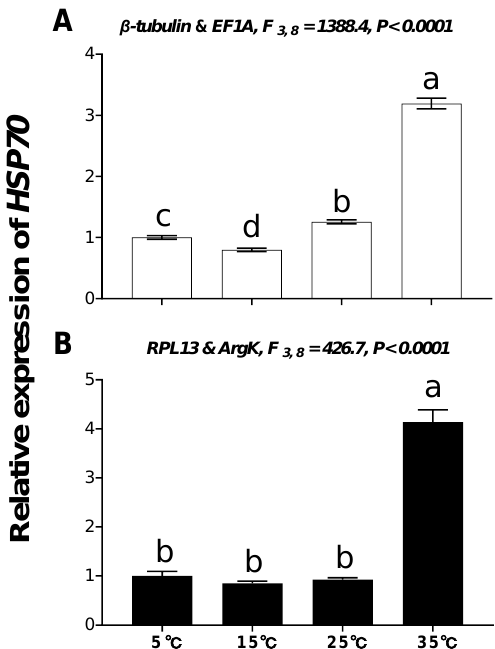
Figure 7. Relative gene expression of HSP70 in di ff erent temperatures. The relative abundance of HSP70 in di ff erent temperatures were normalized to the most stable ( A : β -tubulin and EF1A ) and least stable ( B : RPL13 and ArgK ) reference genes, respectively. The values are means ± SE (Standard error). The significant di ff erences are indicated by di ff erent letters, e.g., a, b, c ( p < 0.05).